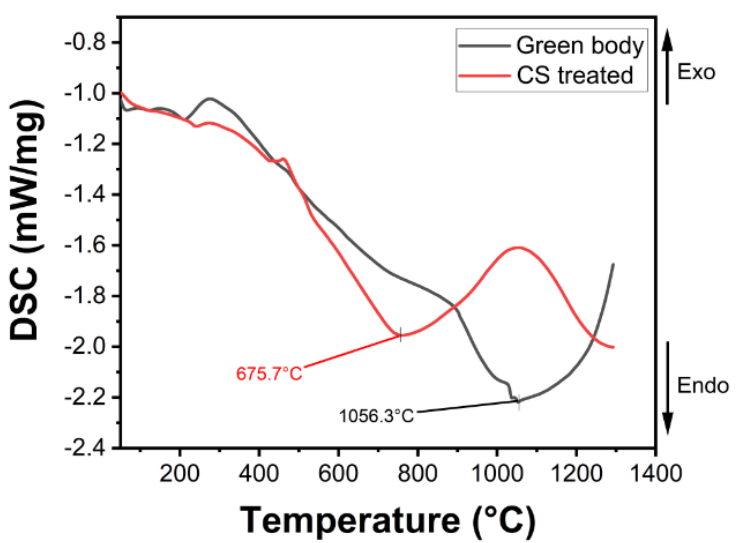
Figure 6. DSC heat flow measurement after printing (G sample) and colloidal silica treatment (GC sample) of a powder bed 3D printed molded body.